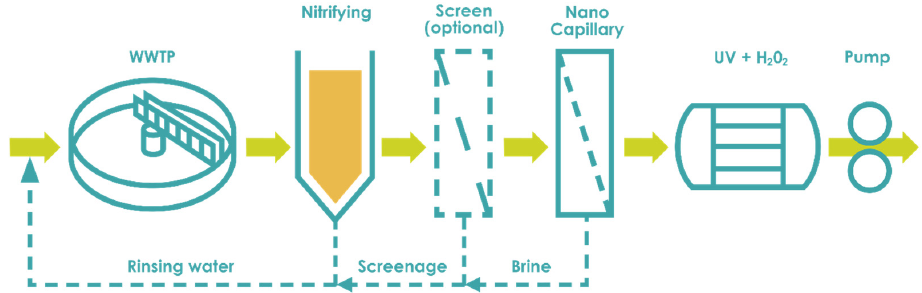
Figure 5. Schematic illustration of water factory water reuse case. Reprinted from [88] with permis- sion from Energy and Resources Factory.